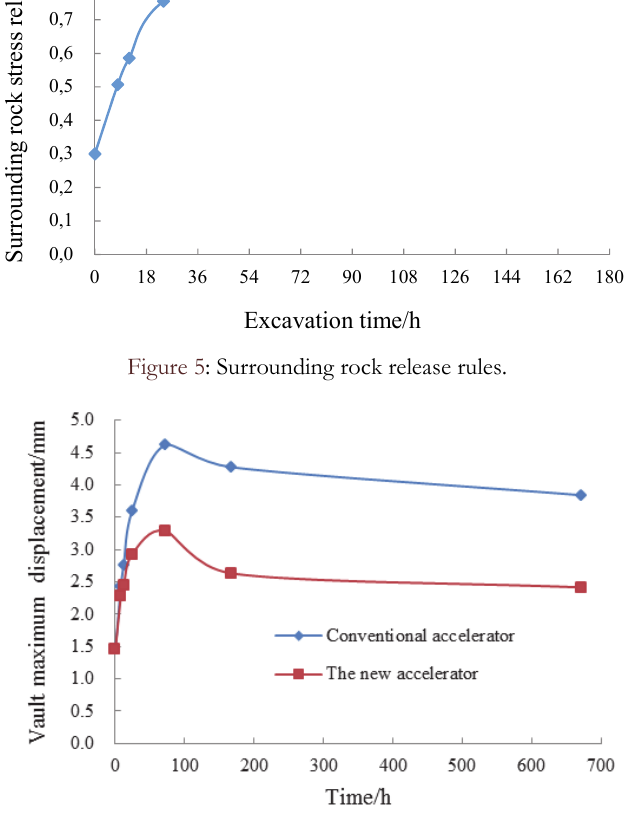
Figure 6: Largest vault settlement